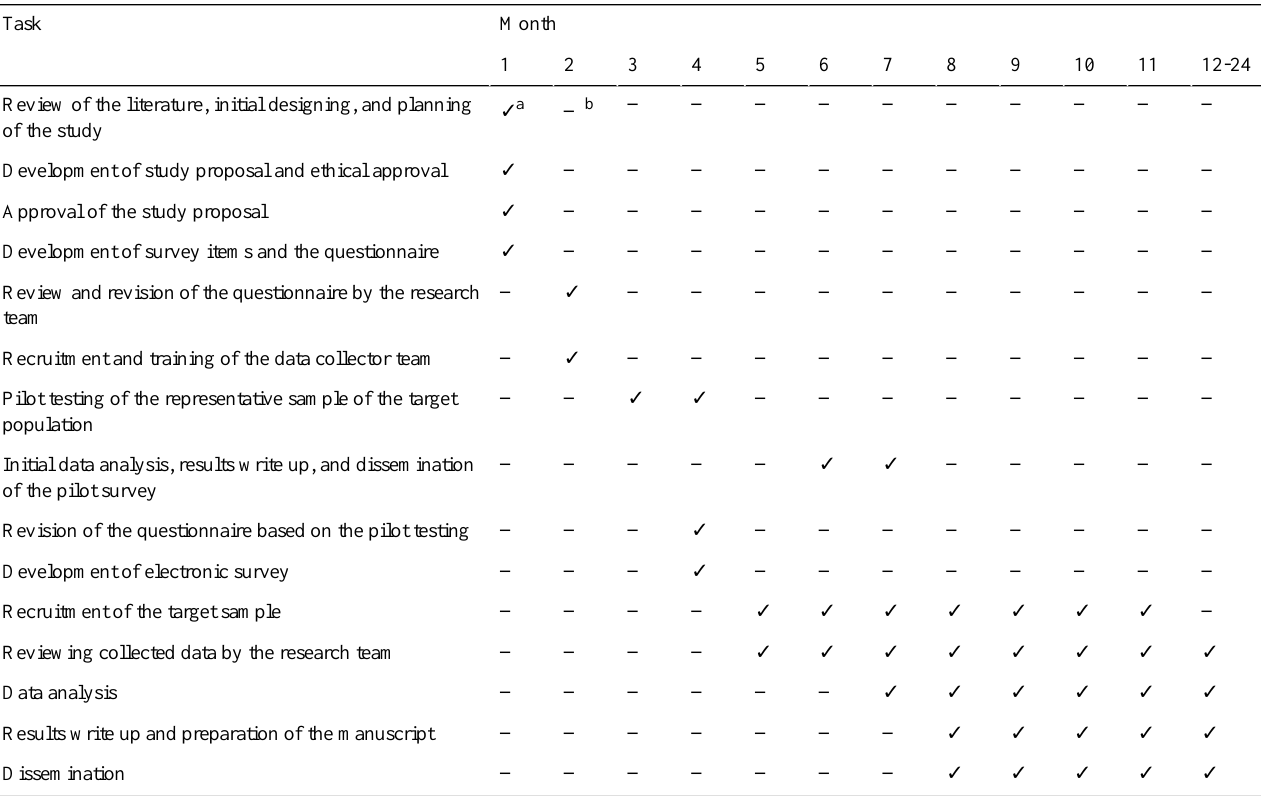
Table 1. Scheduled timeline of the tasks in the CO-VIN-CAP